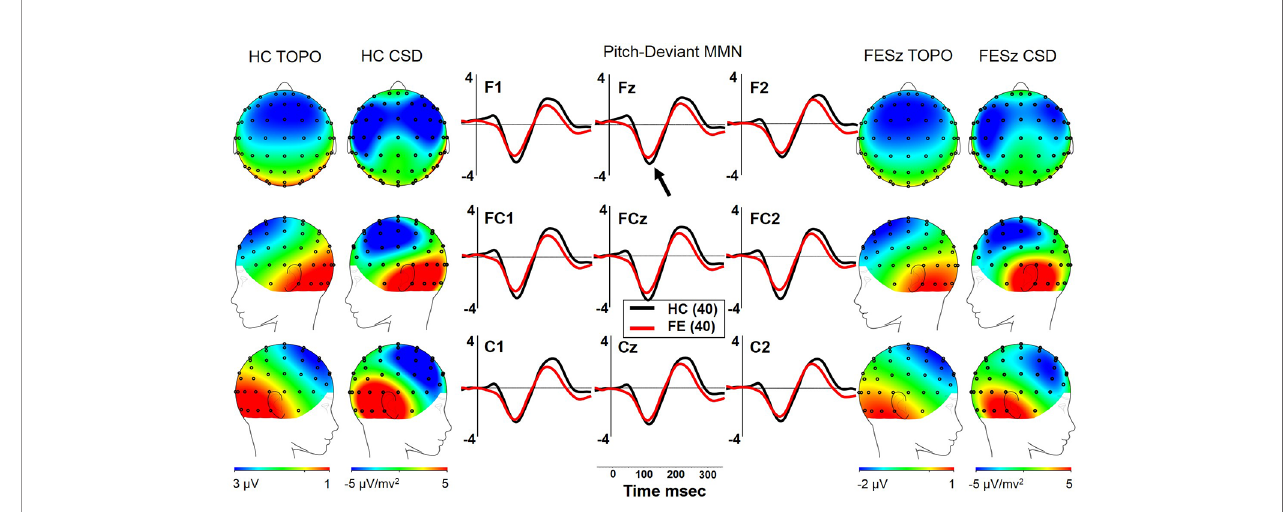
FIGURE 3 | pMMN in the fi rst episode schizophrenia spectrum. HC, Healthy Control subjects; FESz, First Episode Schizophrenia Spectrum subjects; Topo, Voltage topography; CSD, Current Source Density